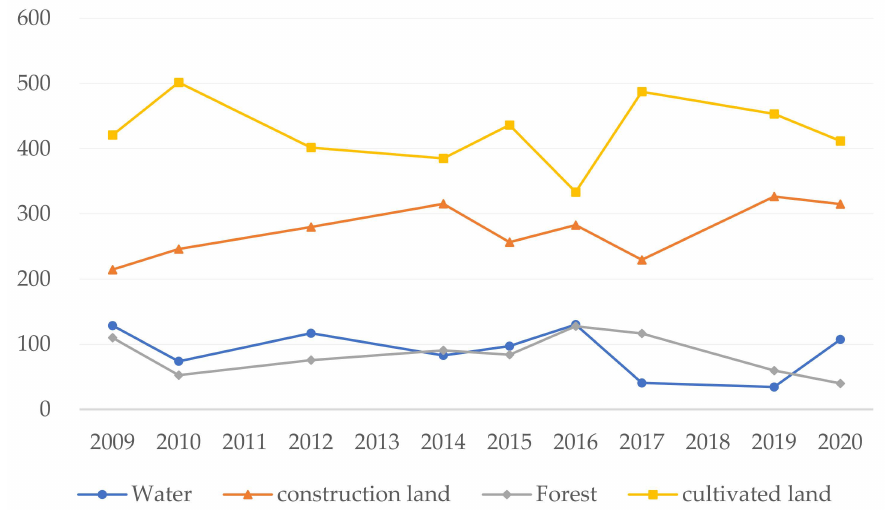
Figure 6. The change trend of land-use type area during 2009-2020. Table 5. Information entropy, dominance, and equilibrium degree of land use.